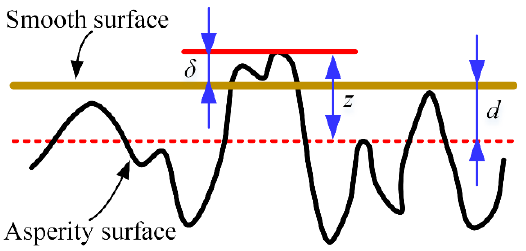
Figure A1. Schematic of the contact between asperity surface and smooth surface.